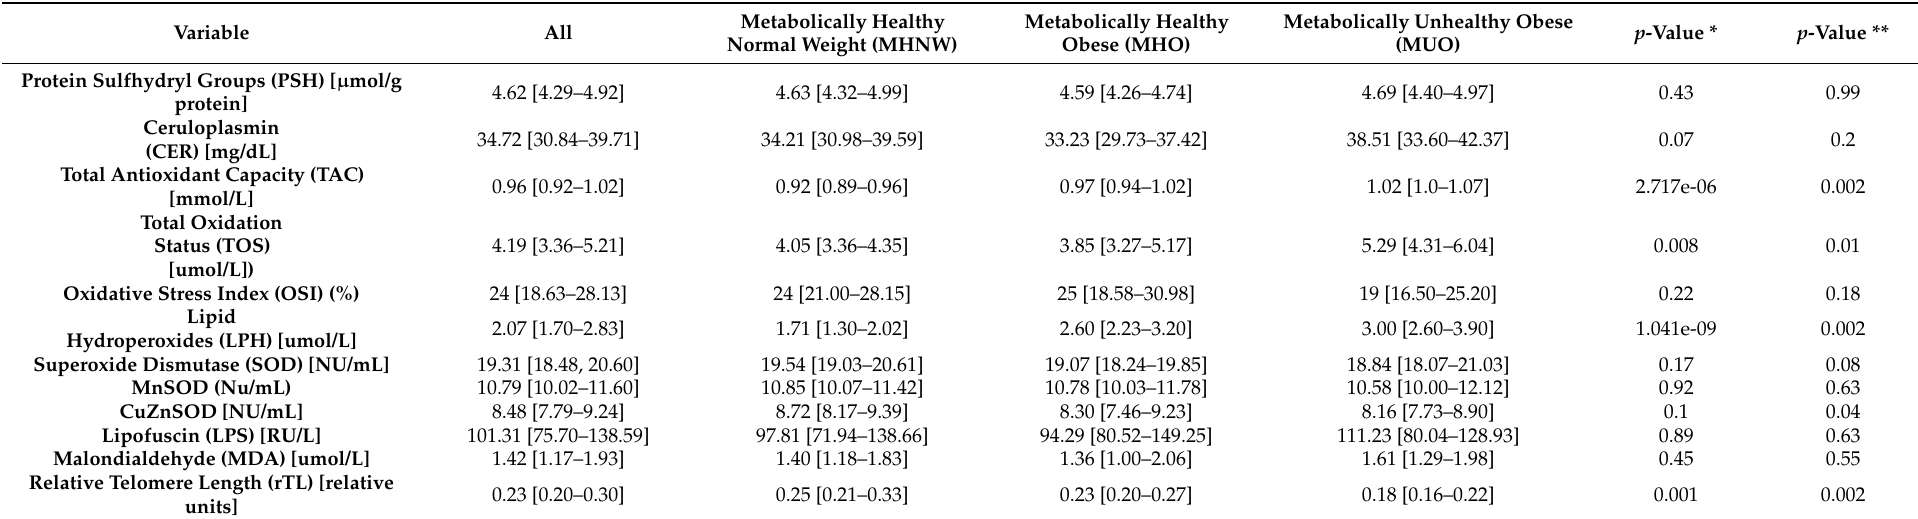
Table 3. Levels of oxidative stress markers among subjects according to metabolic